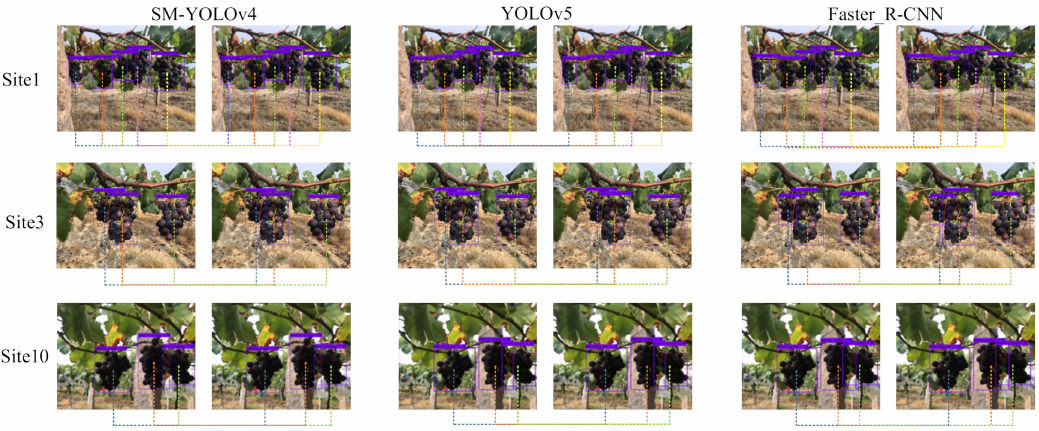
Figure 10. Comparison of the localization results of grape strings using different